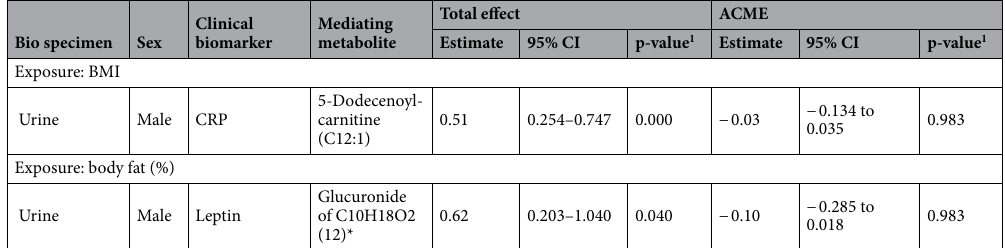
Table 4. Metabolites mediating the association of body composition and habitual food intake with clinical biomarkers. Estimates and confidence intervals are in standard deviations. ACME average causal mediation effect, CRP C-reactive Protein. 1 p-values are corrected for multiple testing by holding the false discovery rate at